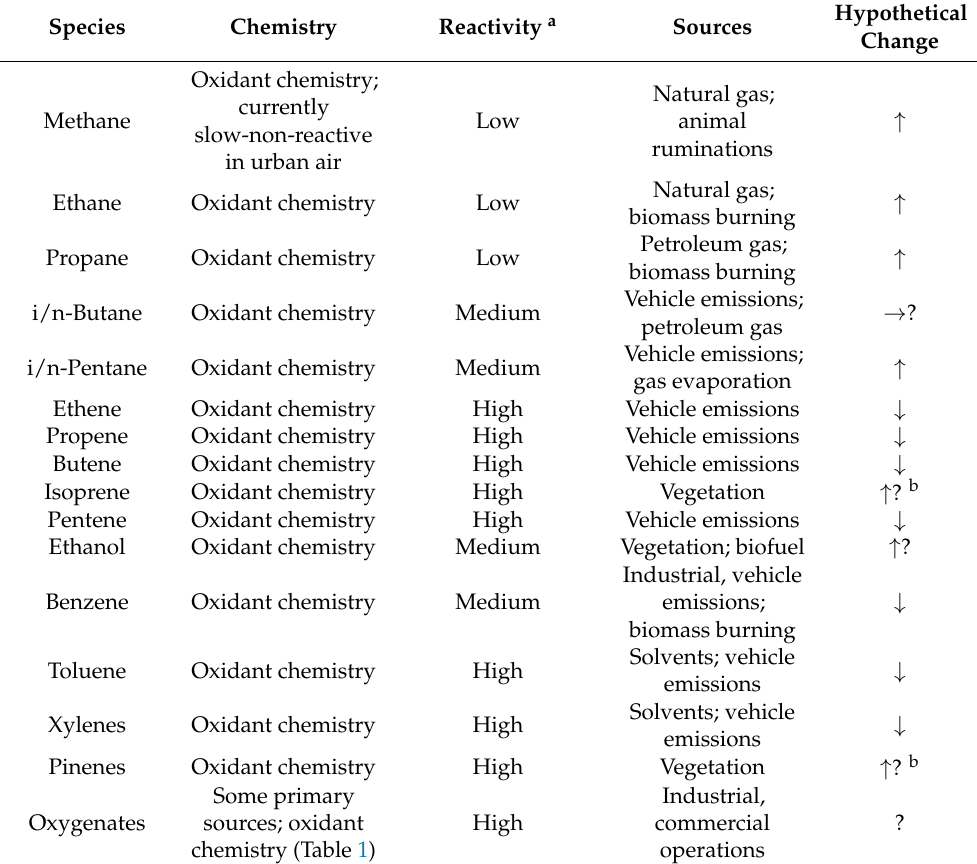
Table 3. Example gaseous organic compounds as potential indicators for chemical